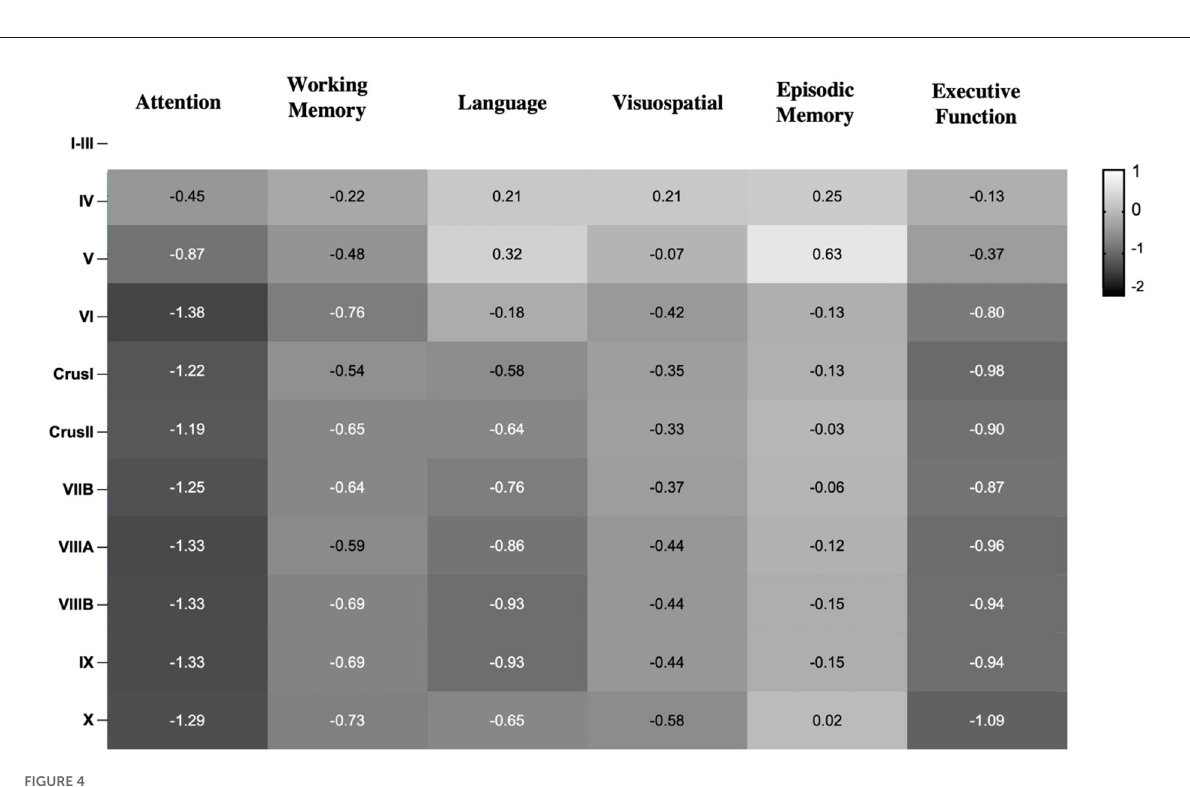
sensorimotor/posterior-cognitive dichotomy in cerebellum (Burciu et al., 2014; Stoodley et al., 2016; Chirino-Pérez et al., 2021). According to the hypothesis of universal